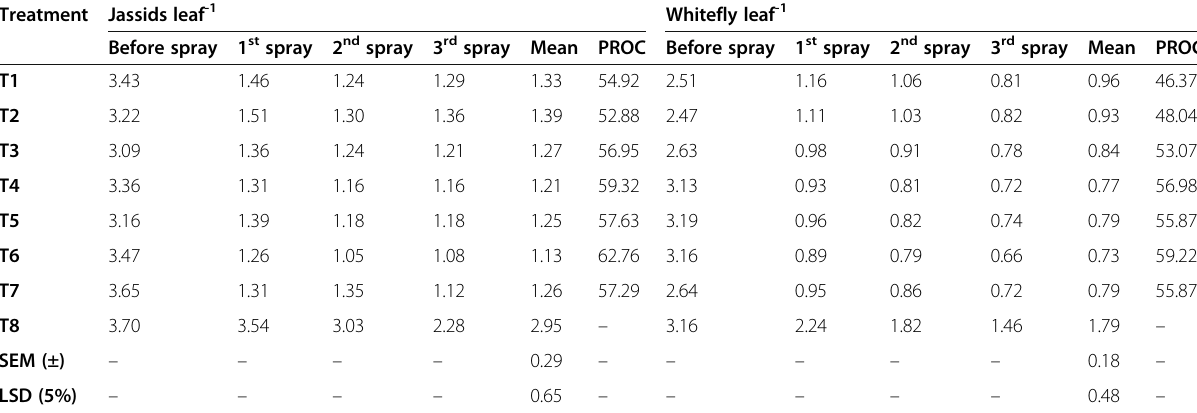
Table 2 Effect of different entomopathogenic fungi and neem oil alone and their 1:1 combination against major sucking pests of okra during 2019 Treatment Jassids leaf -1 Whitefly leaf